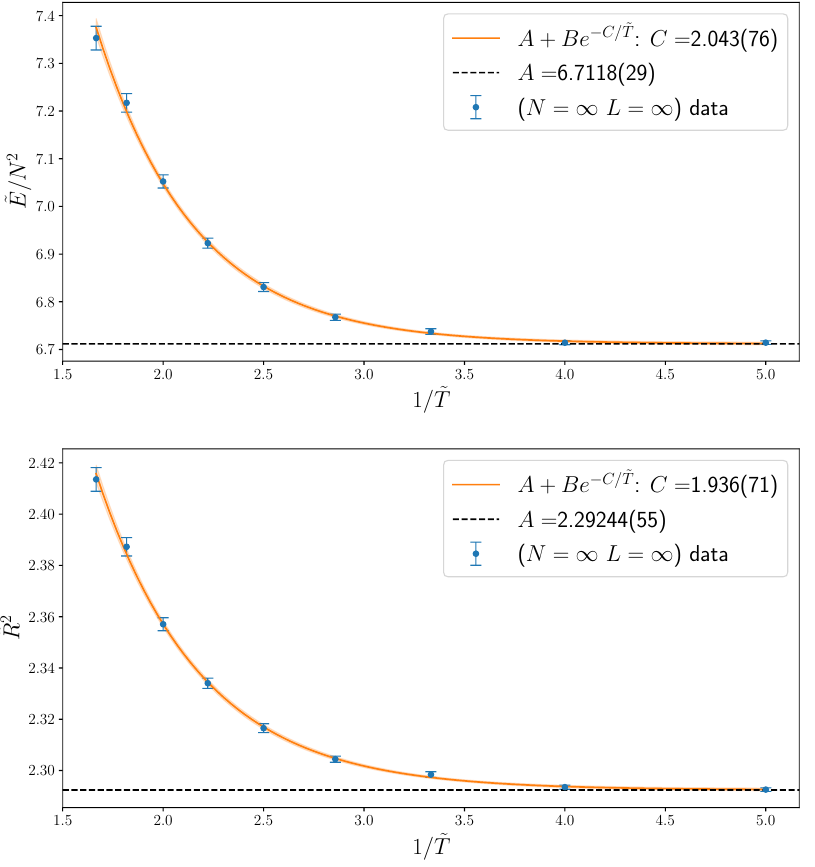
2 = 3 R 2 in the ungauged bosonic matrix model in Figure 2. ~ E=N 2 (cid:21) ( (cid:21) (cid:0) 1 = 3 E ) =N 2 and ~ R 2 (cid:0) (cid:17) (cid:17) the low temperature region, where the gauged counterpart is in the con(cid:12)ning phase. Both behave as A + Be (cid:0) C= ~ T , where C 2 : 0. In the gauged theory, both ~ E=N 2 and ~ R 2 are constant in the ’ con(cid:12)ning phase, and the values obtained in ref. [33] agree with A from the ungauged theory with good